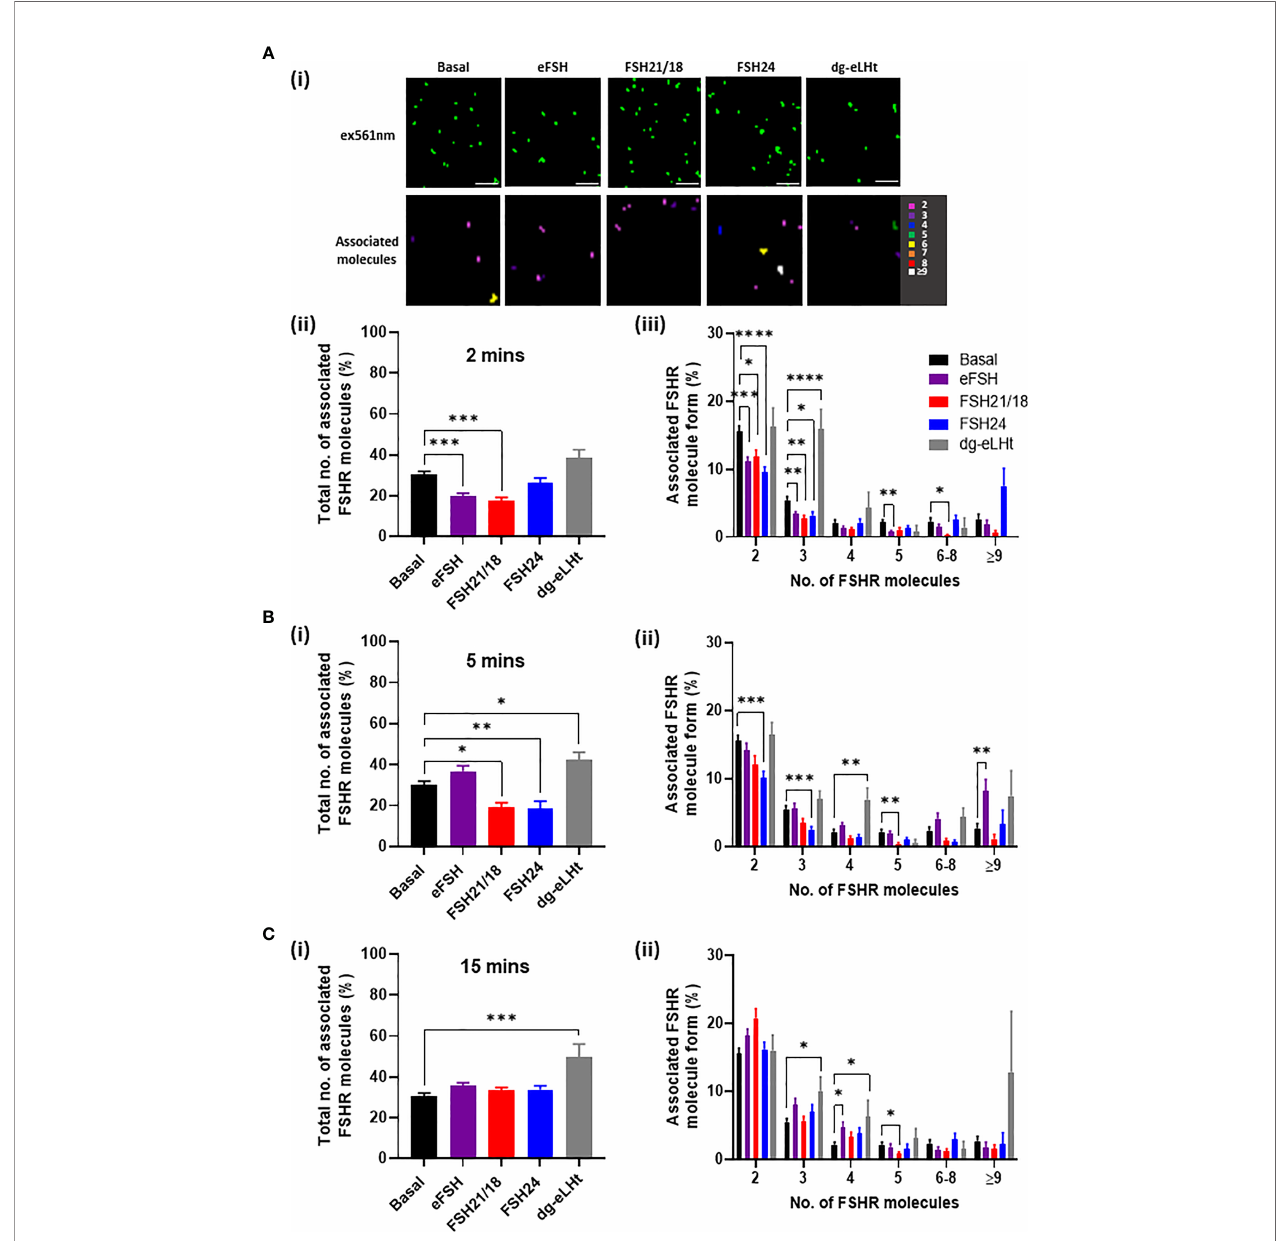
FIGURE 1 | FSH ligands differentially modulate FSHR association. HEK293 cells transiently expressing HA-tagged FSHR were pre-incubated for 30 minutes with CAGE 552-HA antibody and treated with ± 30 ng/ml of eFSH, FSH21/18, FSH24 or dg-eLHt for either (A) 2 minutes, (B) 5 minutes or (C) 15 minutes, fi xed for 30 minutes and imaged via PD-PALM. (Ai) Representative x-y coordinate plots of resolved FSHR molecules (upper panel) and reconstructed heat map of FSHR molecules following 2-minute treatment (lower panel). Images are 2µm 2 from a 5µm 2 area. Scale bars , 500nm. (Aii) , (Bi) and (Ci) Show the percentage of the total number of associated FSHR molecules; data analyzed using ordinary one-way ANOVA. (Aiii), (Bii) and (Cii) Shows the percentage of associated FSHR molecule form; 2 (dimer), 3 (trimer), 4 (tetramer), 5 (pentamer), 6-8, ≥ 9, with data analyzed using multiple unpaired t-tests. All data represent mean ± SEM of 3 independent experiments. * p < 0.05; ** p < 0.01; *** p < 0.001; **** p <